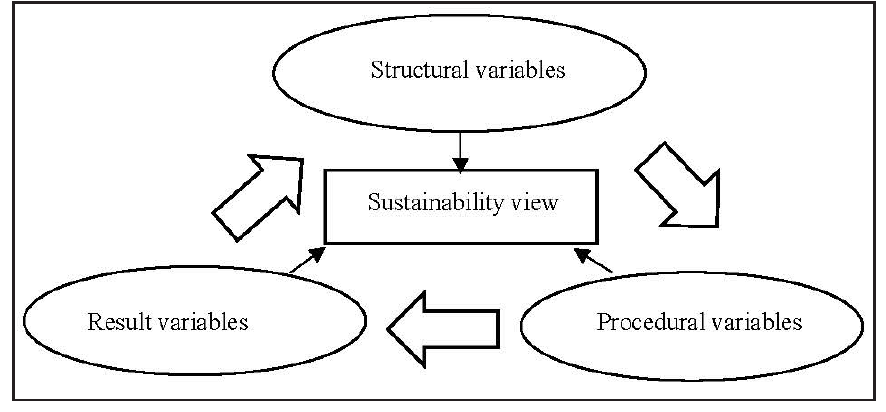
Figure 1: Major Variables Relevant to Boards for Corporate Orientation Toward the Sustainability